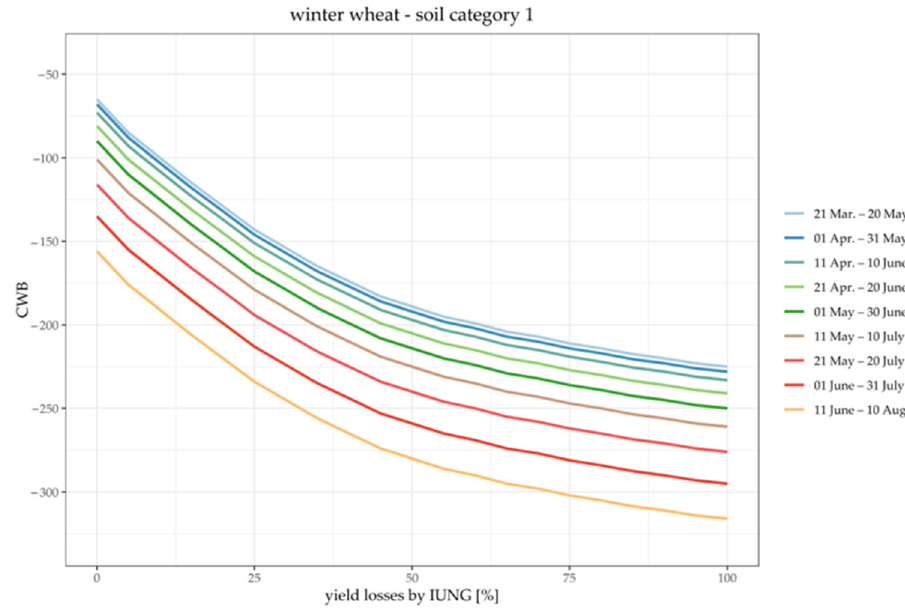
Figure 4. Yield reduction in winter cereals grown in soils of the 1st category of soil drought vulnerability depending on the CWB values. Source: own study (IUNG-PIB).